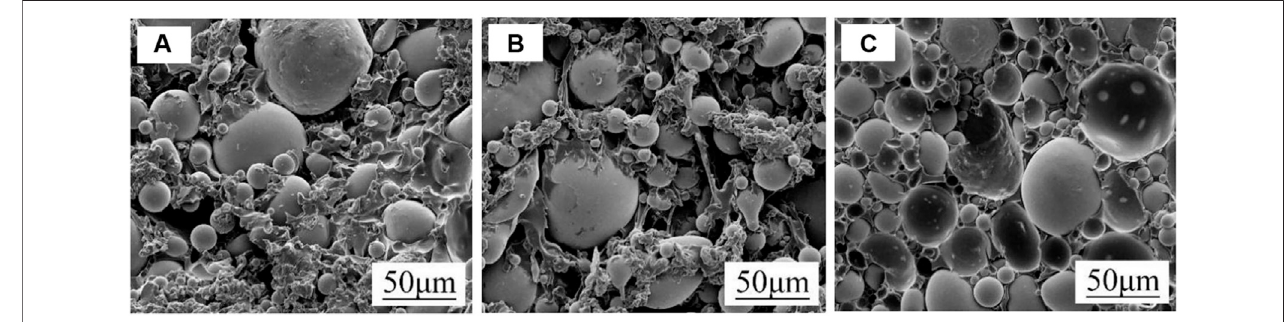
FIGURE 3 | SEM image of cross sections with different iron powder content: (A) 92.3 wt% FeSiB (B), 92.6 wt% FeSiB, and (C) 92.8 wt% FeSiB.